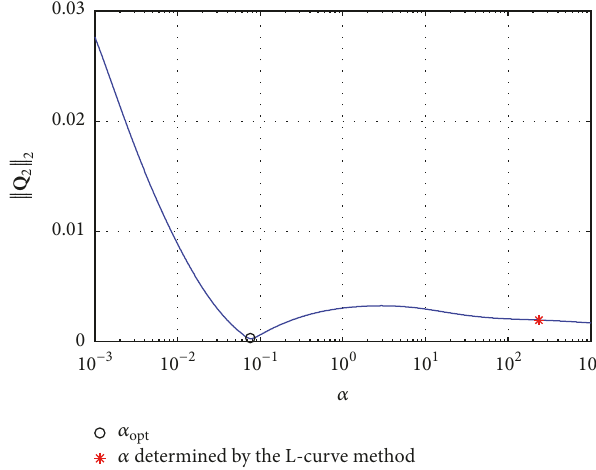
Figure 8: L-Curve of the normal surface velocity reconstruction for the vibrating plate at 600Hz.